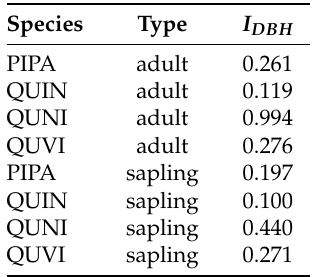
Table A19. Species DBH increment parameters.